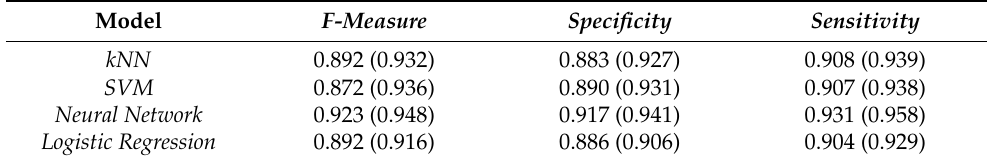
Table 2. Lung disease characterisation